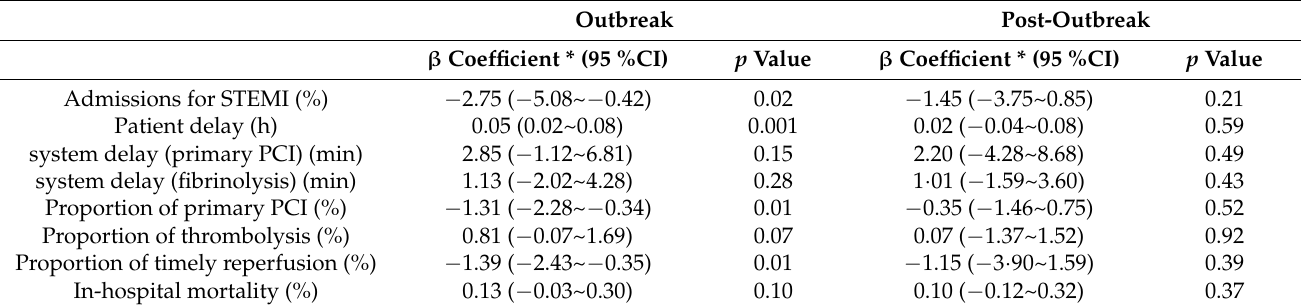
Table 3. Relationship between prevalence of COVID-19 and changes in STEMI management and prognosis in China during the outbreak and post-outbreak periods. Outbreak